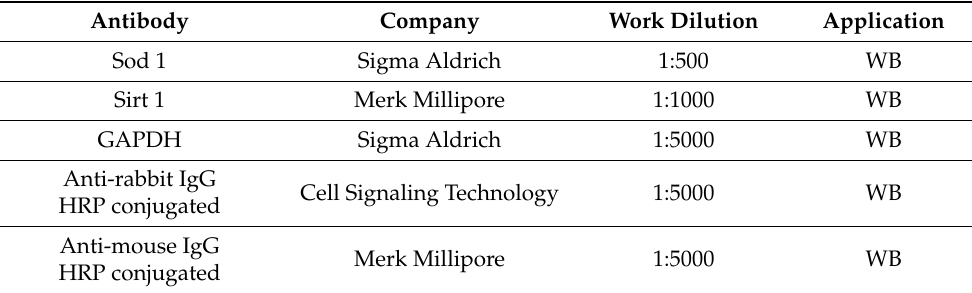
Table 1. List of antibodies for Western blotting.